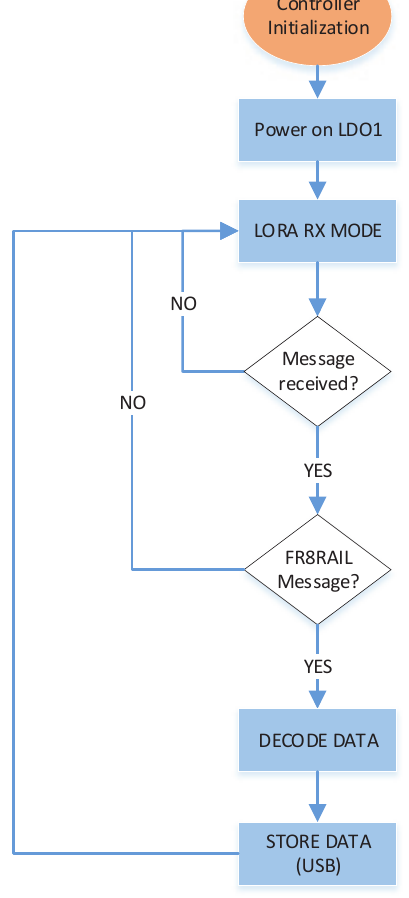
Figure 5. Flow chart of the Master node